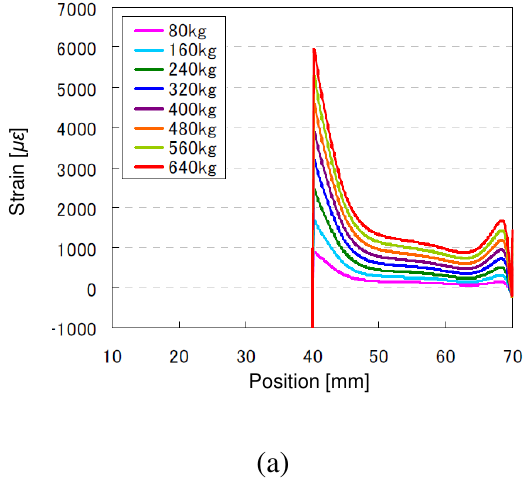
Figure 6. Strain distribution of the epoxy side at the adhered boundary in (a) longitude, (b) peel and (c) shear